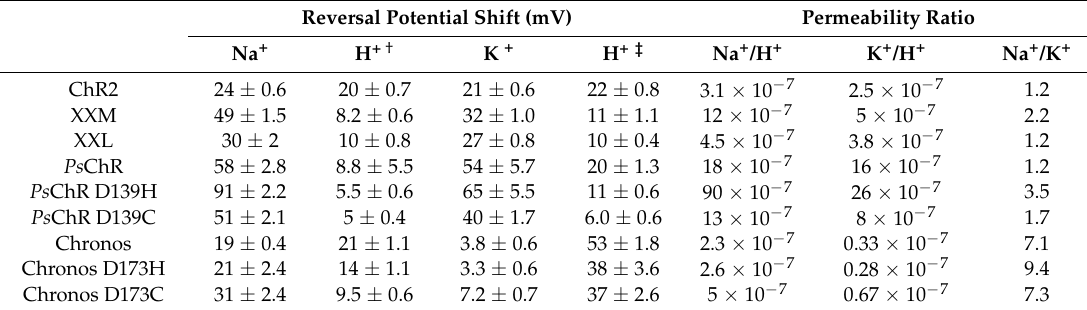
Table 2. Ion selectivity of ChR2, Ps ChR, and Chronos